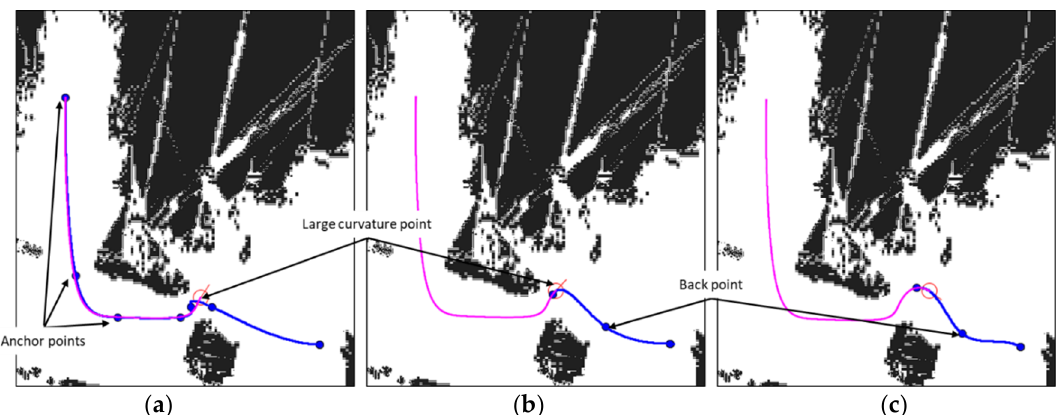
Figure 9. ( a ) Robot moves to the position where curvature is large enough, and deviates from desired trajectory; ( b ) After robot deviates from the trajectory, robot will create a subtrajectory to the back